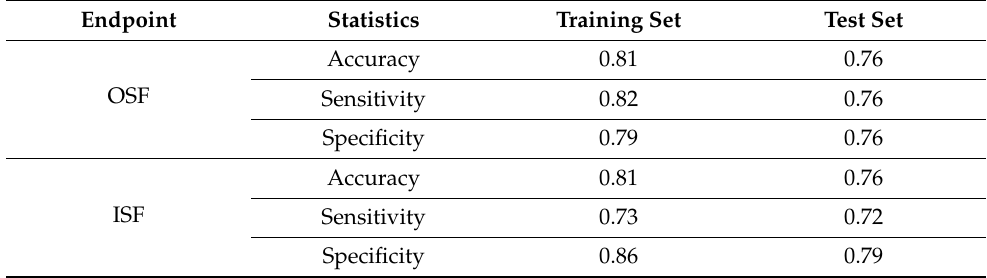
Table 1. Statistics for the final oral and inhalation classification models (as implemented in VEGA).